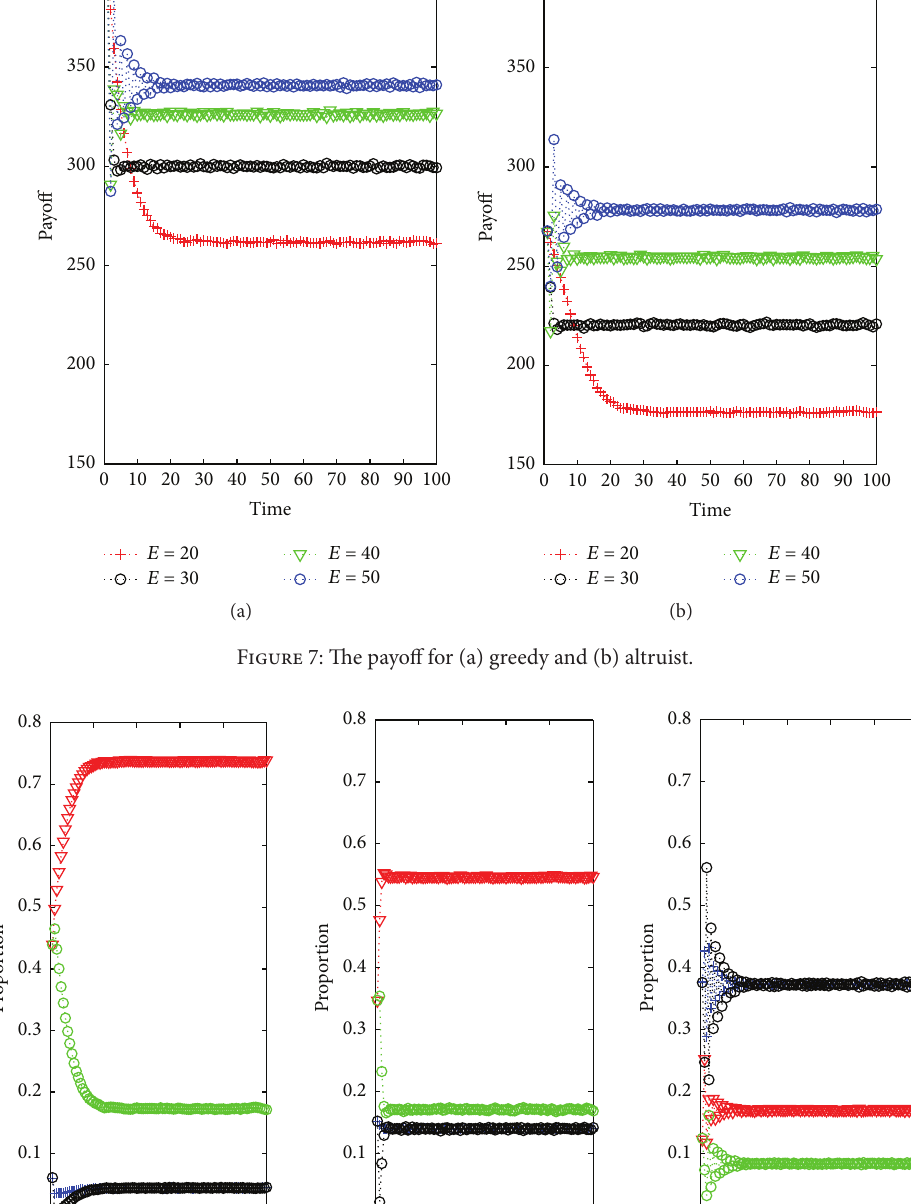
the fractions of A → G and G → A increase